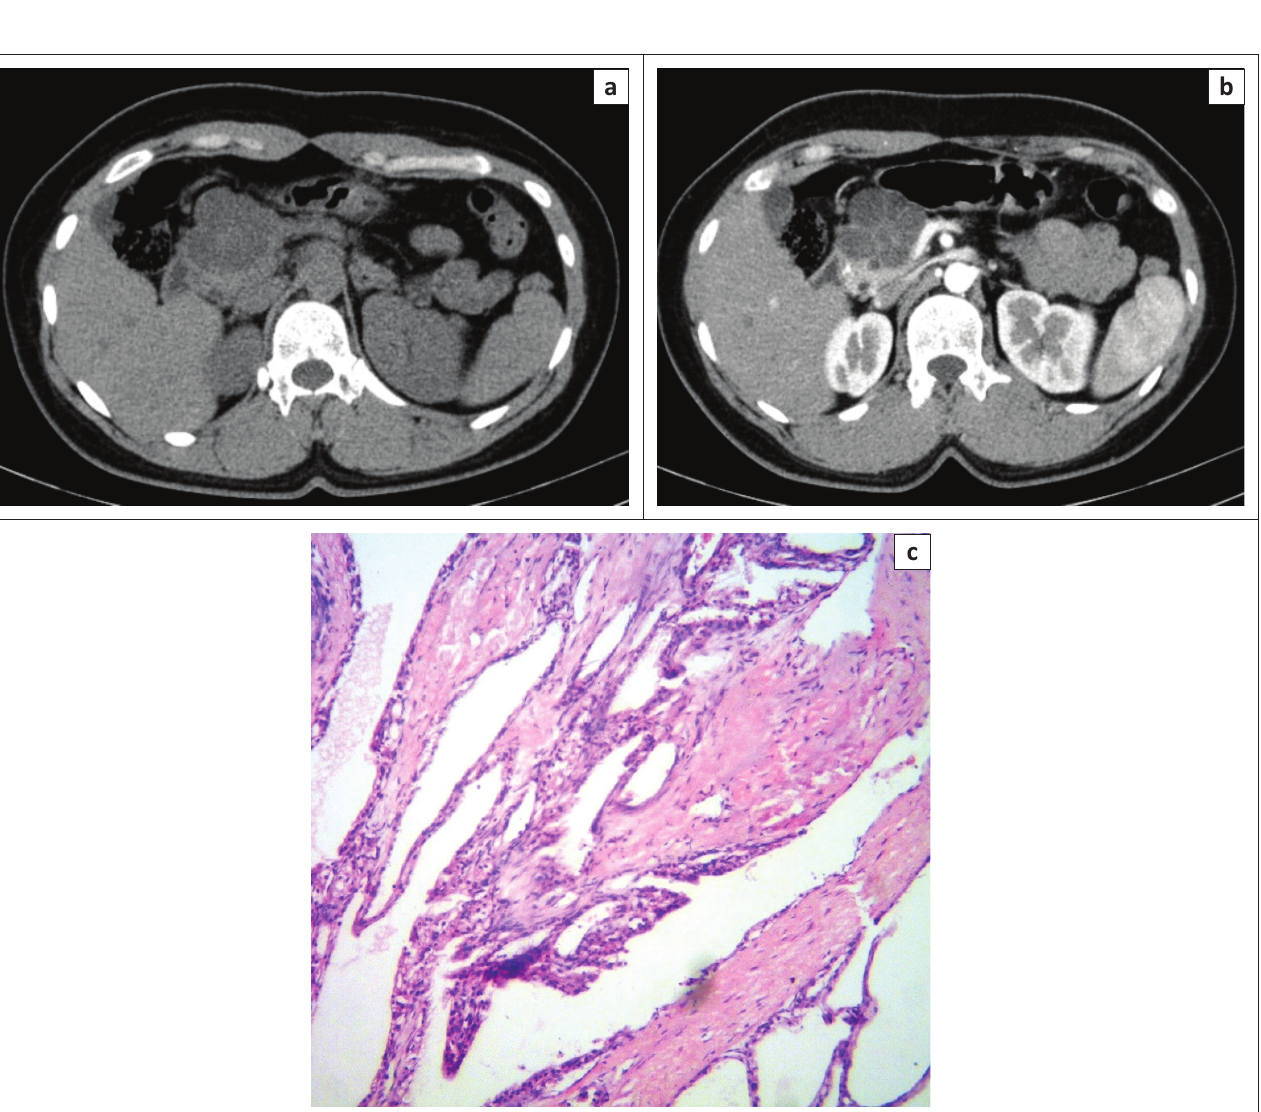
FIGURE 1: Axial non-contrast-enhanced computed tomography image (a) in a 37-year-old female patient showing fluid density lobulated lesion in the head of pancreas. Axial contrast-enhanced computed tomography image (b) in the same patient showing a multiloculated cystic mass in the head of pancreas with enhancing septations, a central stellate scar and no definite wall enhancement, suggestive of serous cystadenoma. High power magnification (40X) photomicrograph (c) of the same patient confirmed the diagnosis of micro-cystic serous